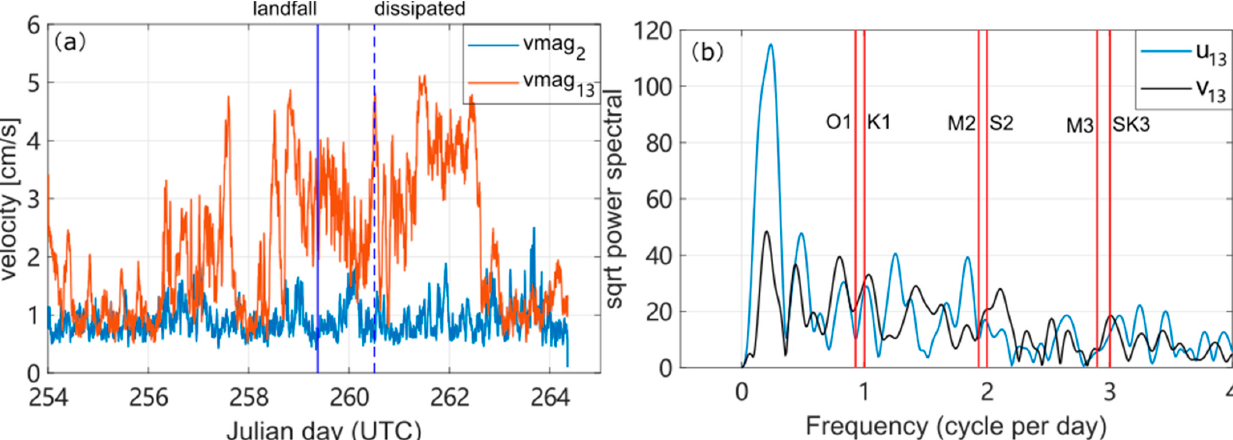
Figure 3. Velocity magnitude at layer 2 and layer 13 (2.6 m and 13.6 m above the lake bottom, respectively) during the measurement in September 2018 ( a ) and the corresponding power spectra of zonal and meridional velocity components at layer 13 ( b ). The vertical solid and dashed lines in ( a ) specify the landfall and decay of Typhoon Mangkhut, and red lines in ( b ) indicate the diurnal tidal frequencies of principal lunar tide O1 and lunisolar tide K1 with periods of 25.82 h and 23.93 h, semi-diurnal tidal frequencies of principal lunar M2 and principal solar S2 with periods of 12.42 h and 12 h, and the overtides M3 and SK3 with higher frequencies due to non-linear effects.